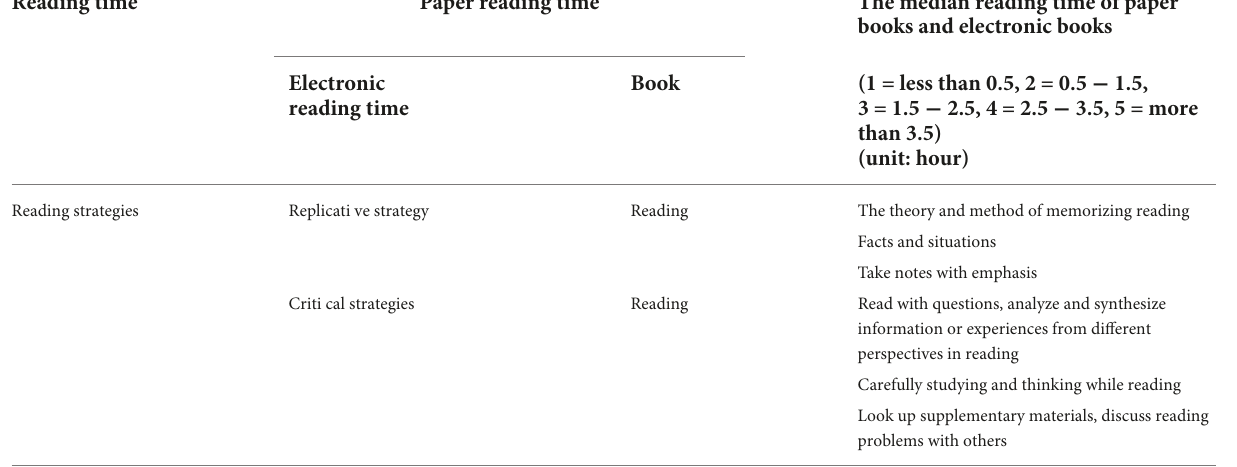
TABLE 1 Specific indicators of reading engagement. Reading time Paper reading